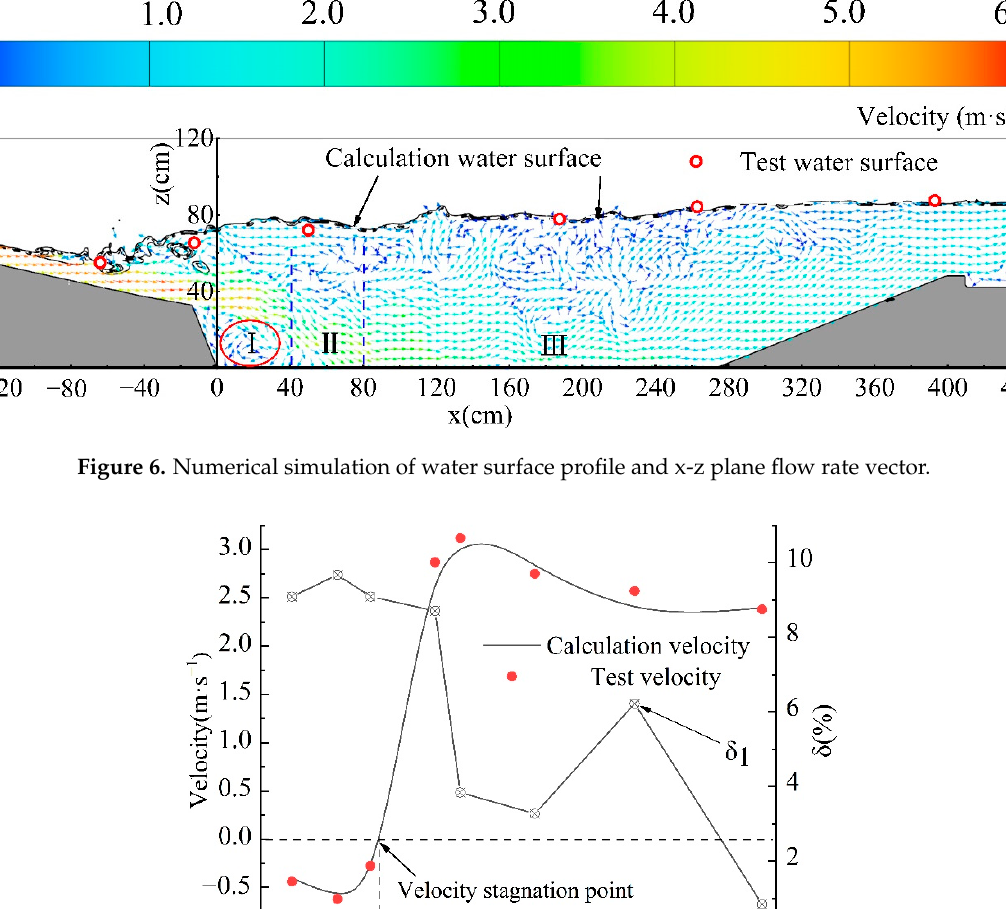
Figure 6. Numerical simulation of water surface profile and x-z plane flow rate vector.